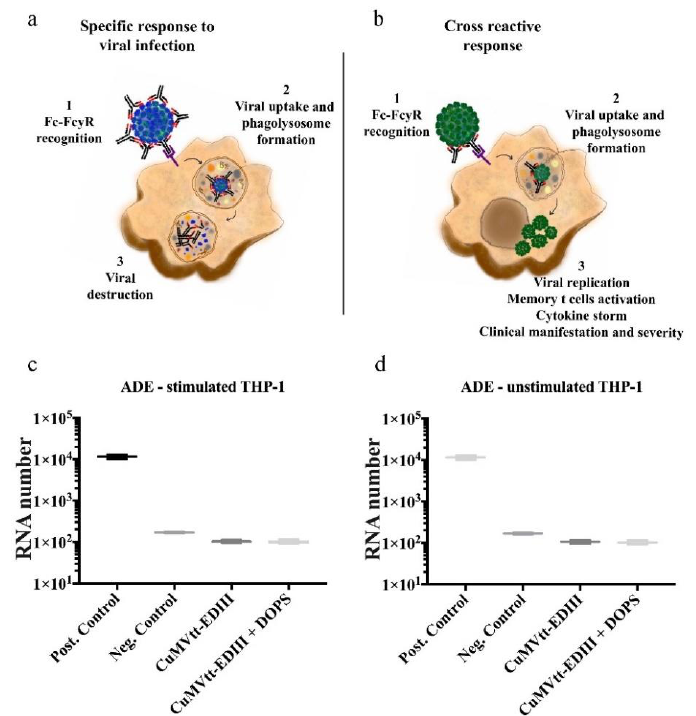
Figure 6. Vaccine-induced antibodies do not cause antibody-dependent enhancement (ADE).